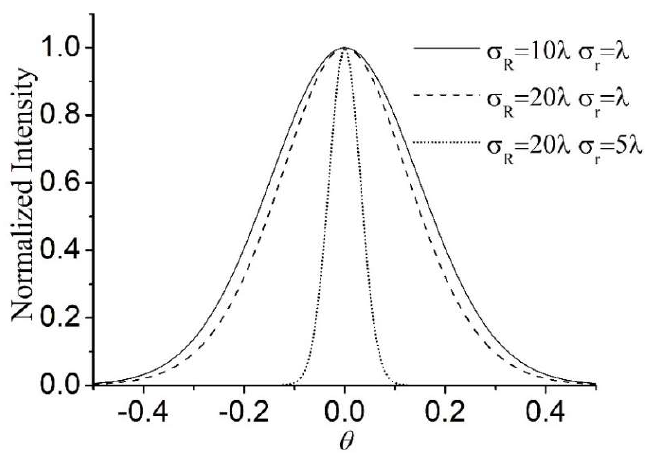
Figure 4. The normalized intensity of the scattered partially coherent Gaussian Schell-model plane-wave pulse versus θ for different values of σ R and σ r of the quasi-homogeneous random medium.